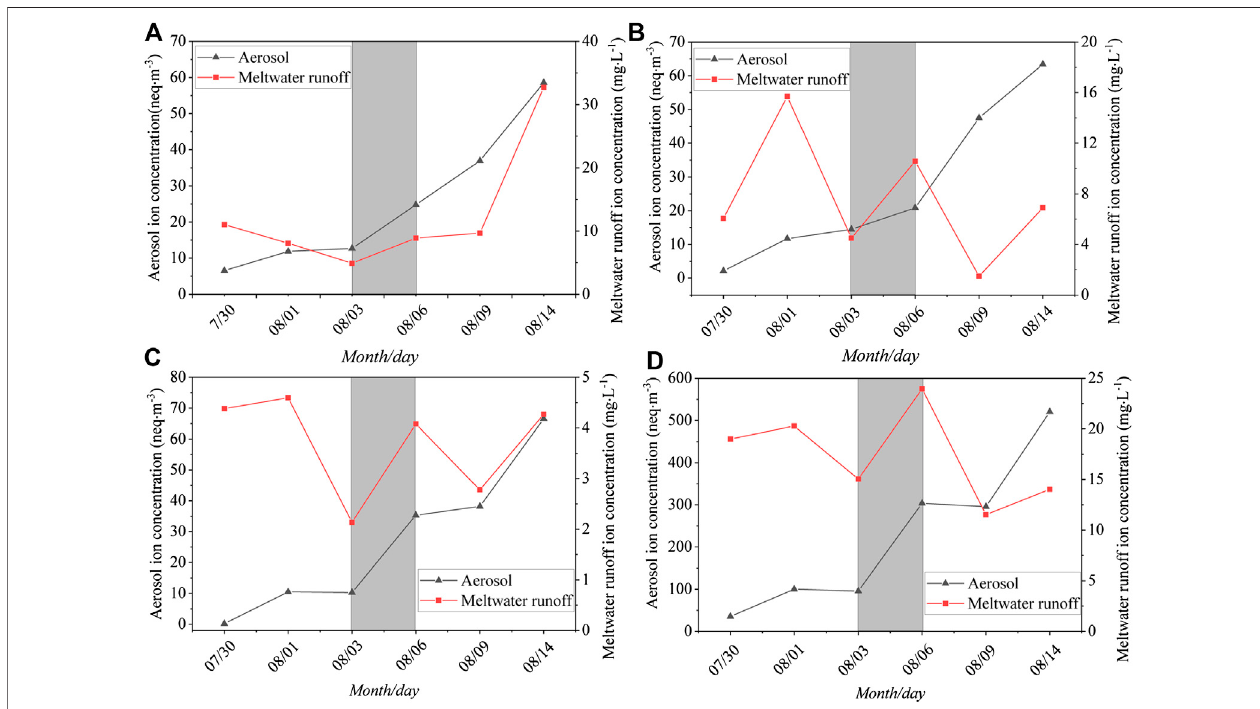
FIGURE 6 | Temporal variations in typical ions in aerosol and meltwater runoff samples in 2008. (A) SO 42- ; (B) Na + ; (C) Mg 2+ ; (D) Ca 2+ .